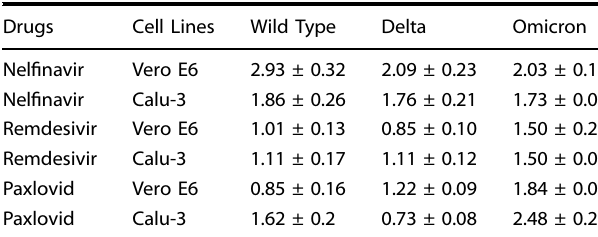
Table 1. The EC 50 ( μ M, mean ± sd) of the drugs against different SARS-CoV-2 mutants